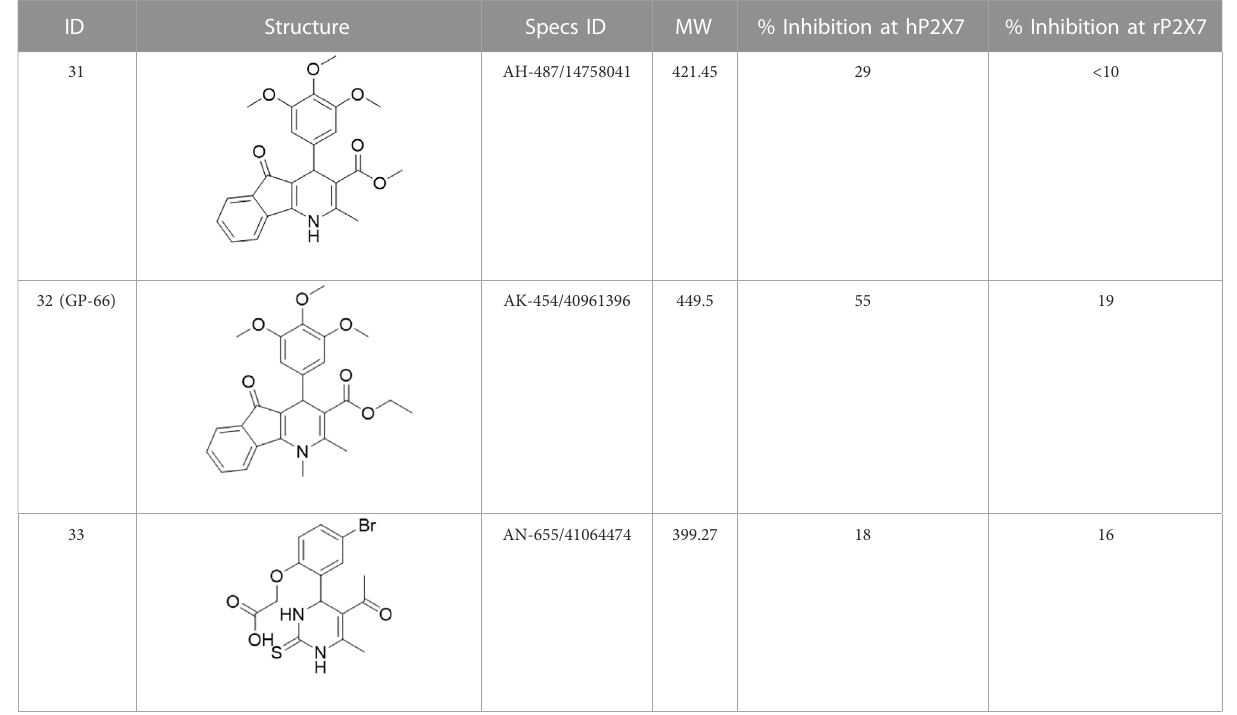
TABLE 1 ( Continued ) List of compounds identi fi ed by virtual screening in the P2X4 ATP-binding pocket (numbered 1 – 17) and GP-25 analogues (numbered 18 –